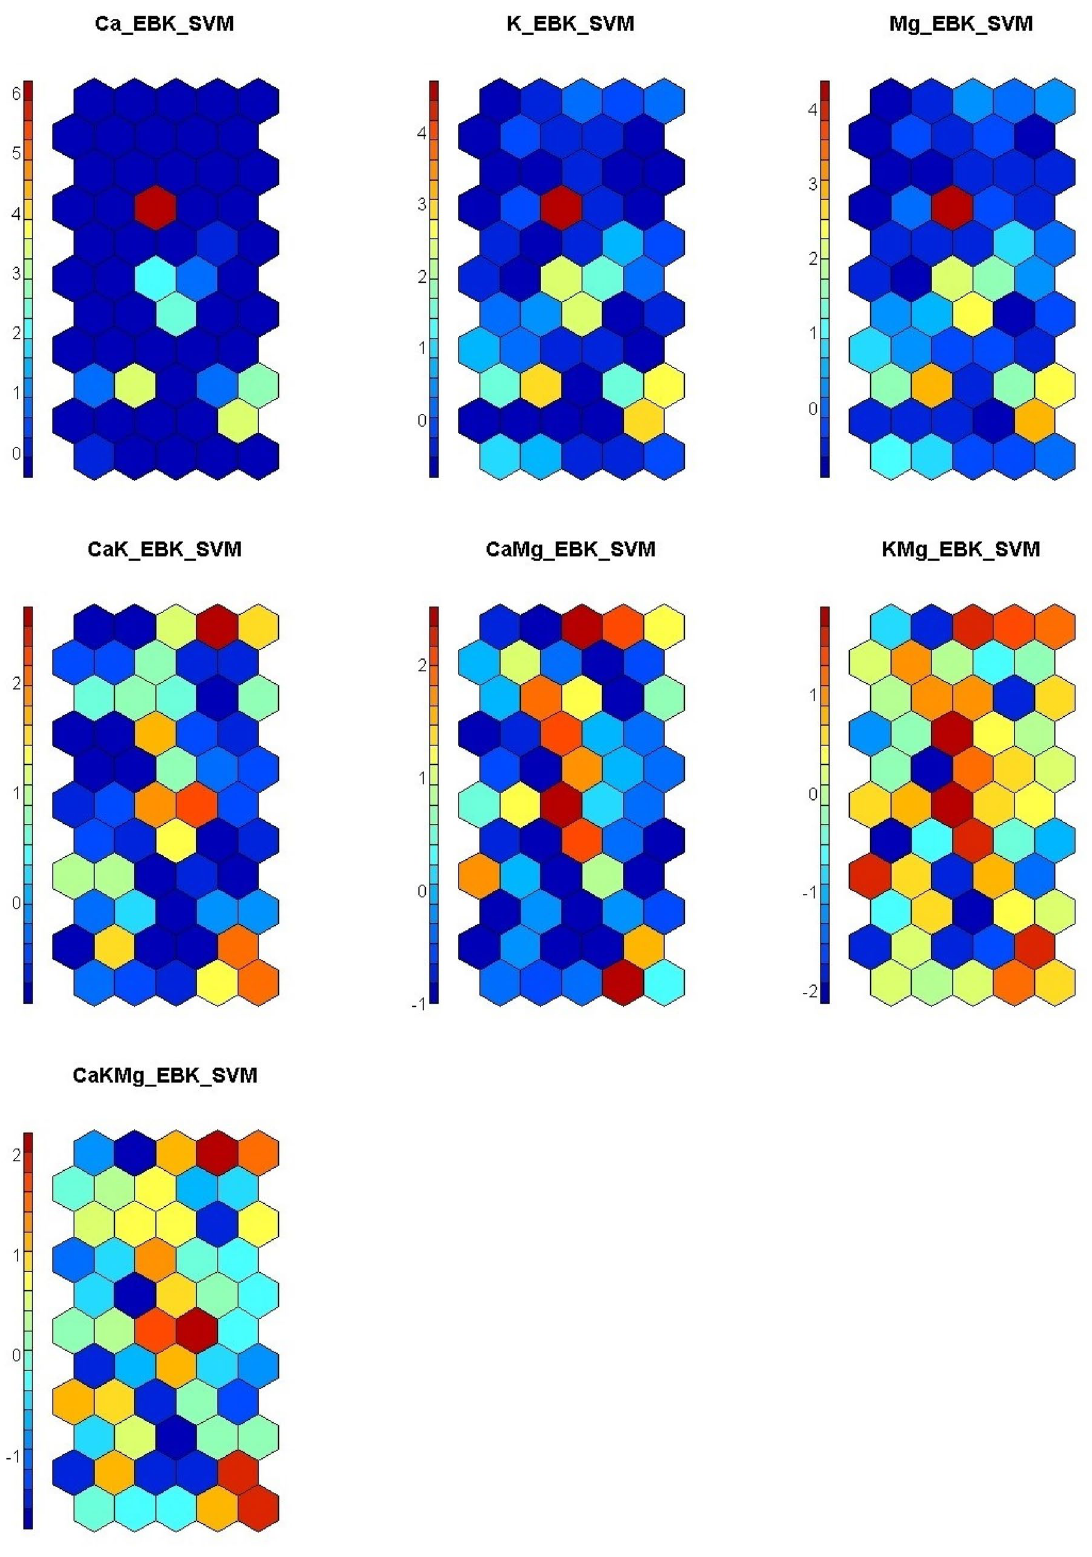
Figure 6. Component planes for each empirical bayesian kriging -support vector machine (EBK_SVM_SeOM) variable output. [The SeOM maps were created with RStudio (Version 1.4.1717: https:// www. rstud io.